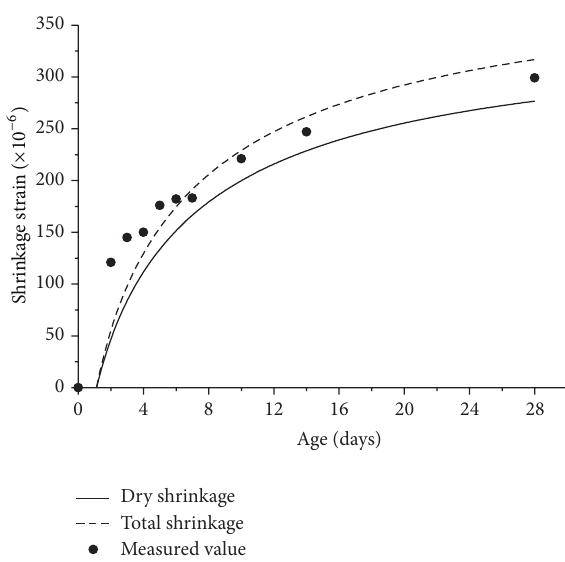
Figure 5: Measured shrinkage strains and analyzing results.